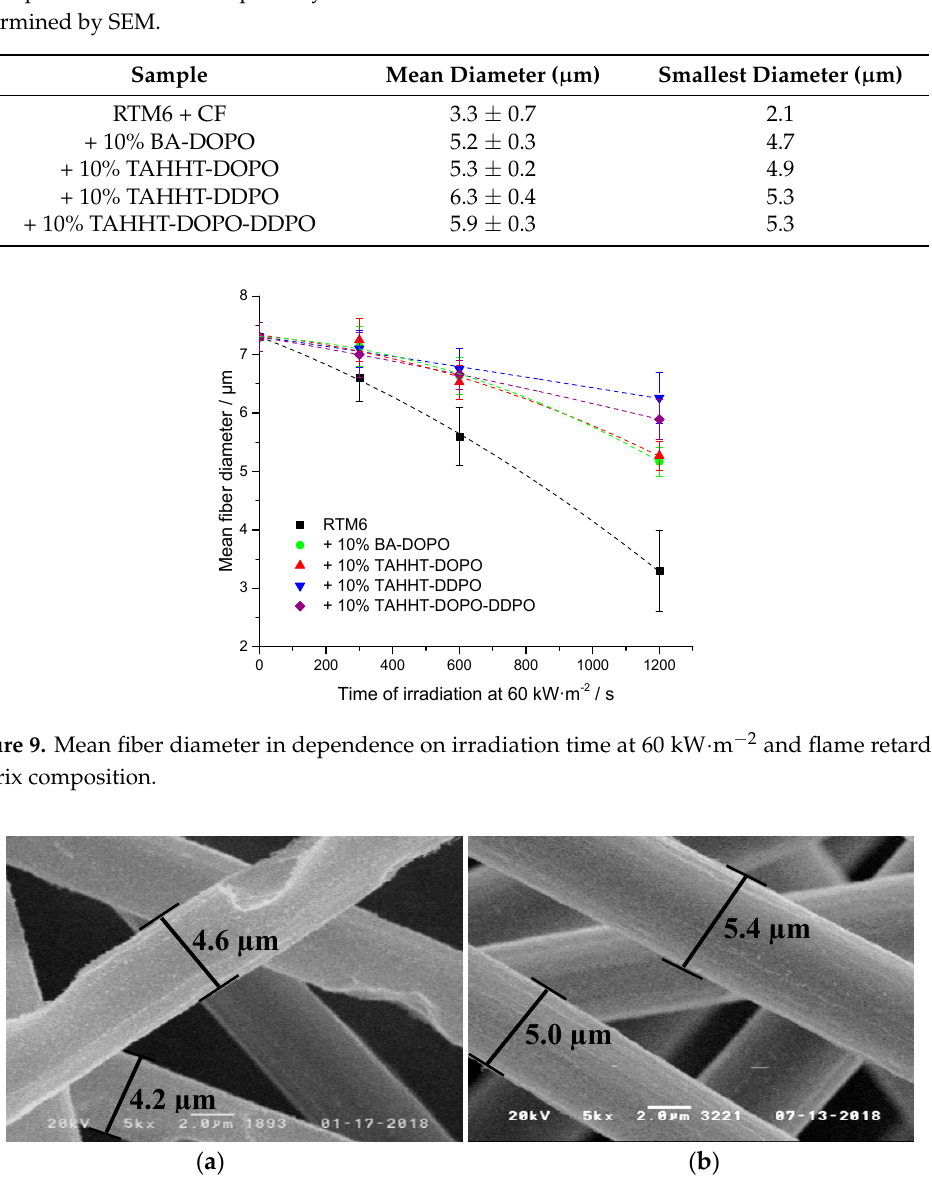
Figure 10. SEM images of carbon fibers after irradiation at 60 kW·m − 2 : a : RTM6 + CF, 1200 s; b : RTM6 + 10% TAHHT-DOPO-DDPO, 1500 s.